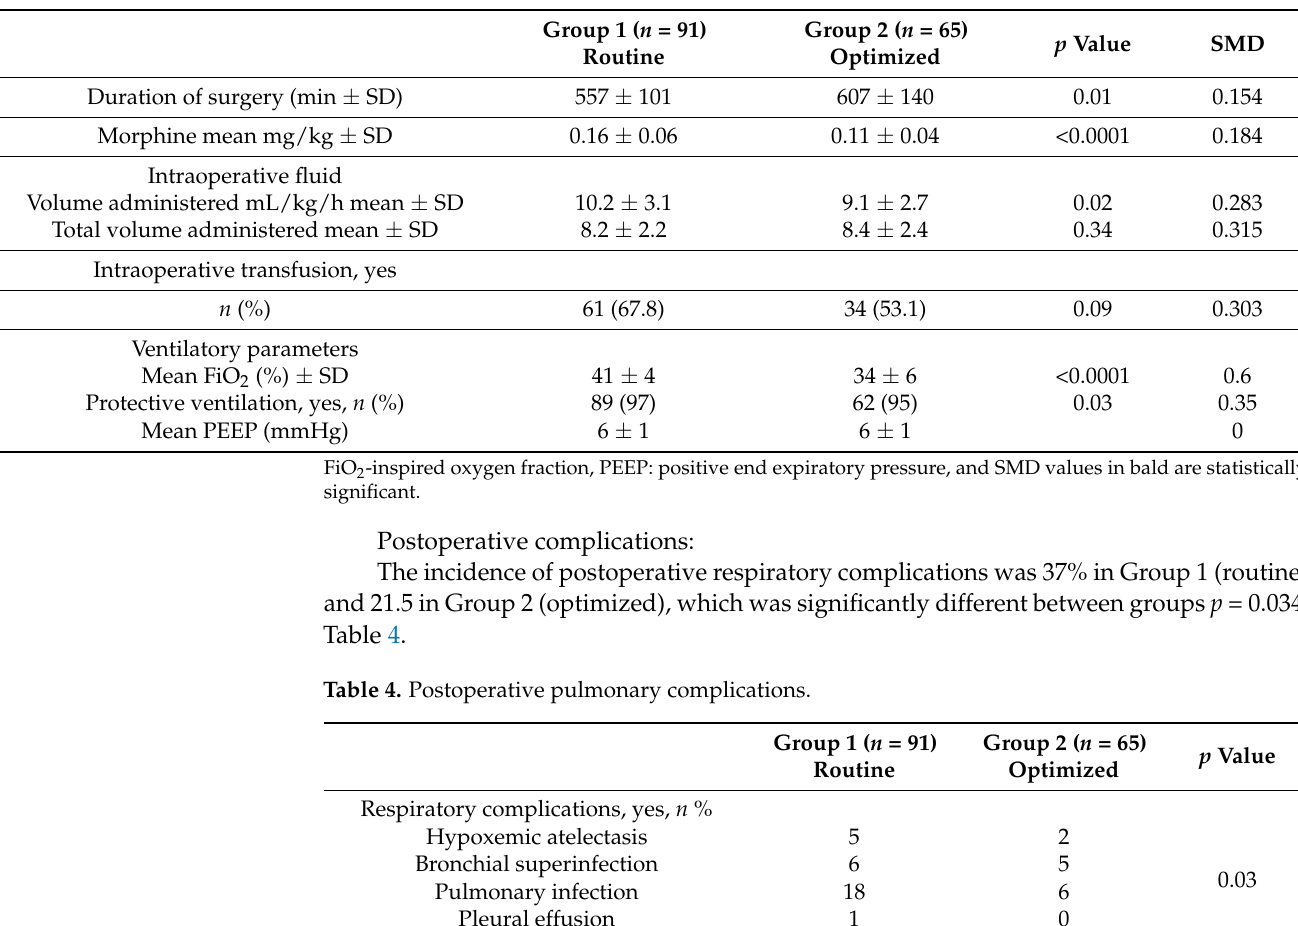
Table 3. Intraoperative events.